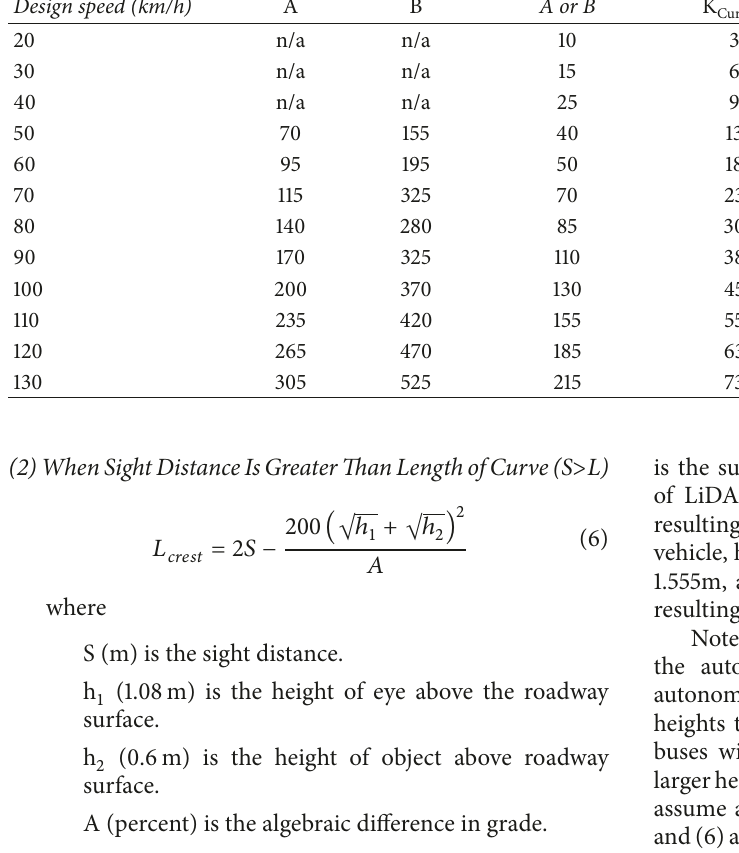
Table 2: Comparing DSD and K Values at different design speeds, current values retrieved from Green Book [29]. DSD (m) Sag curve Crest curve Current Proposed Rate of vertical